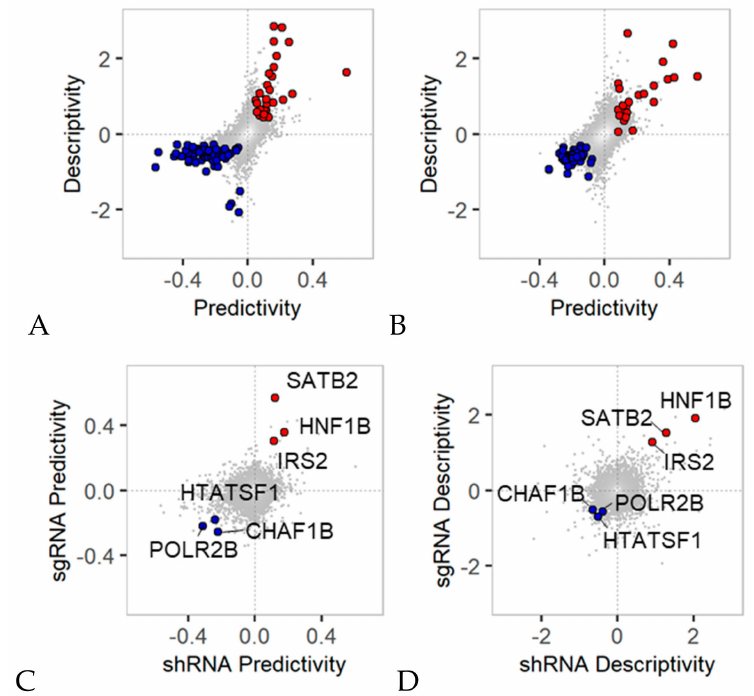
Figure 4. Bidirectional predictivity and descriptivity analyses of gene expression in colon cancer cell lines. ( A , B ) Predictivity vs. descriptivity between mRNA expression and shRNA / sgRNA e ffi cacy are plotted. Hit genes showing positive or negative scores with a p -value < 0.01 in terms of both predictivity and descriptivity were selected. The numbers of positive hits from the shRNA and sgRNA analyses were 30 and 23 (red circles), respectively, and the numbers of negative hits from the shRNA and sgRNA analyses were 60 and 51 (blue circles), respectively, as shown in the plots. ( C , D ) Common hits obtained from shRNA and sgRNA analyses were comparatively plotted in predictivity and descriptivity plots. The common hit genes with positive scores (red circles) are HNF1 homeobox B ( HNF1B ), SATB homeobox 2 ( SATB2 ) and insulin receptor substrate 2 ( IRS2 ). The common hits genes with negative scores (blue circles) are chromatin assembly factor 1 subunit B ( CHAF1B ), HIV-1 Tat specific factor 1 ( HTATSF1 ), and RNA polymerase II subunit B ( POLR2B